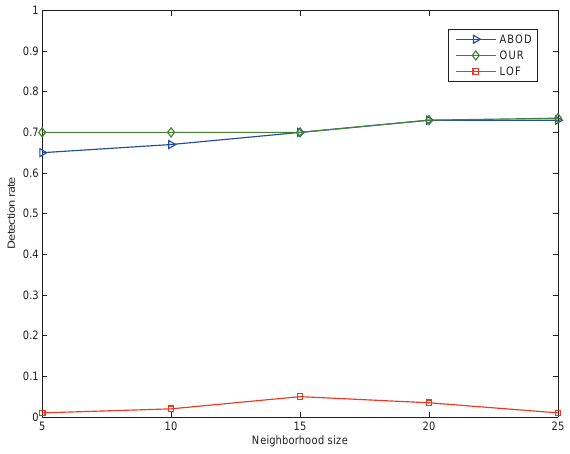
Fig. 4. Outlier detection rate over different neighborhood size by ten independent